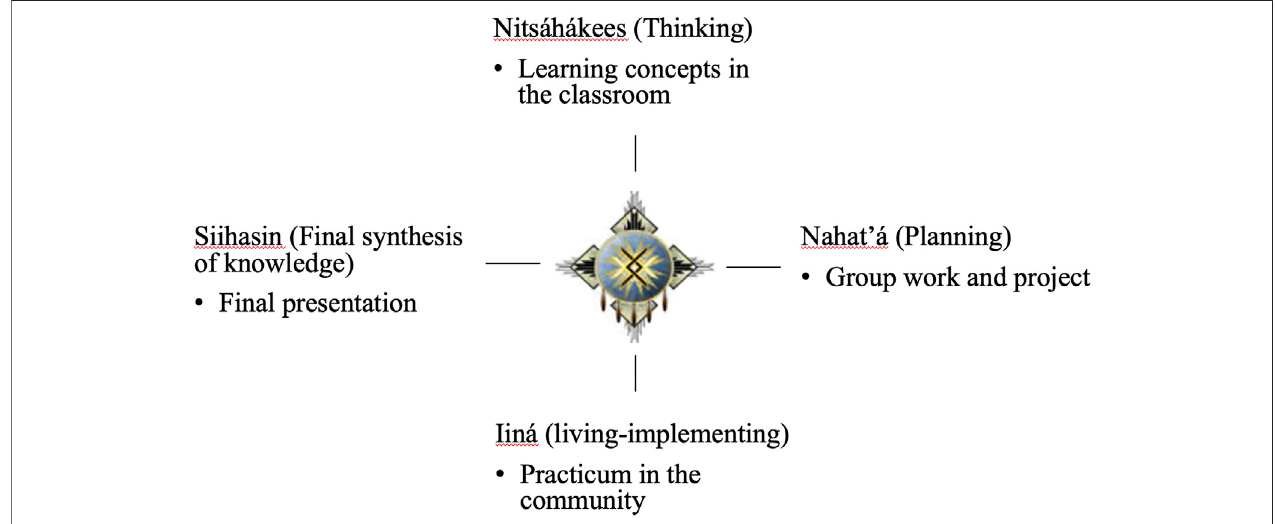
FIGURE 1 | Summer Research Enhancement Program organization based on the Diné Education Philosophy framework.